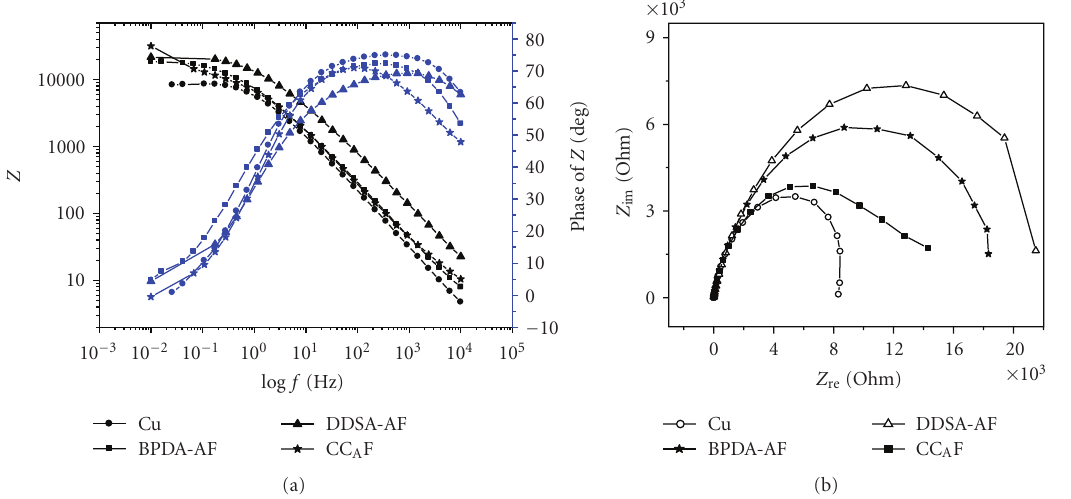
Figure 4: Bode (a) and Nyquist (b) diagrams for bare and resin coated